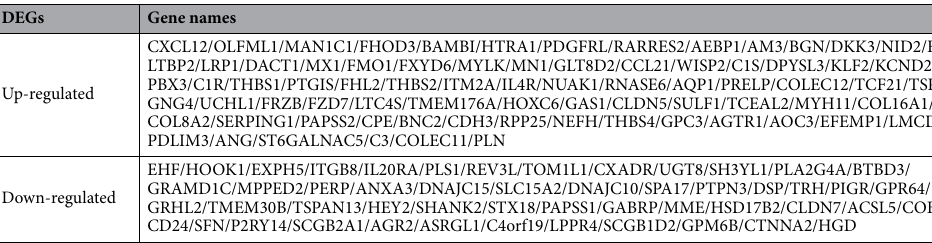
Table 2. 129 DEGs in EMs were identified by integrated bioinformatics, with 78 up-regulated and 51 down- regulated.